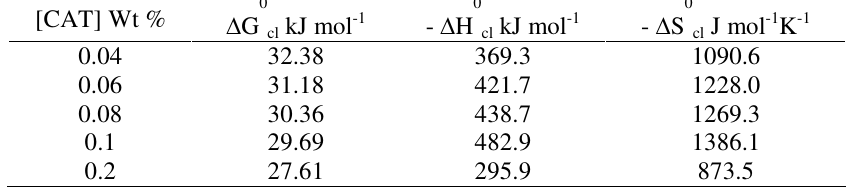
Table 4. Thermodynamic parameters of Tween-40/CAT